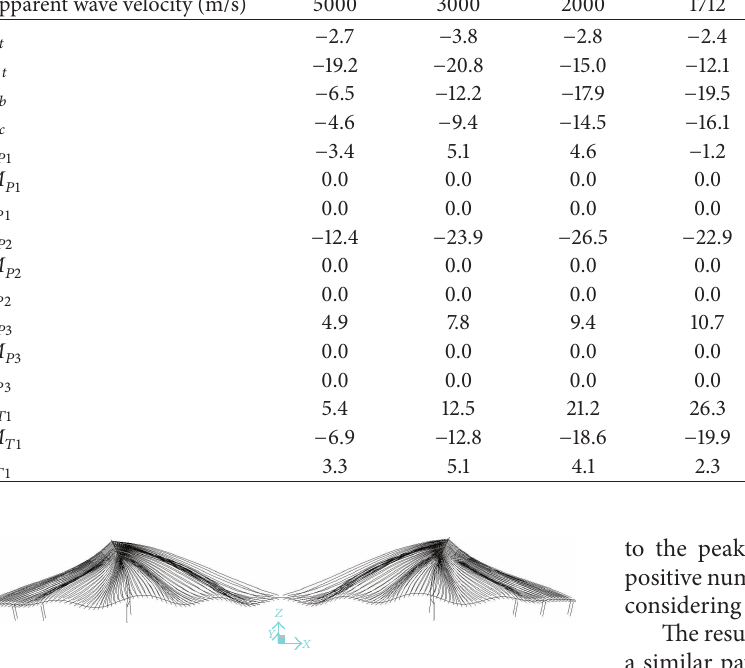
Figure 10: The 26th mode shape of the